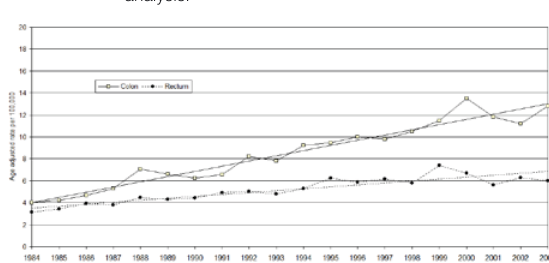
Figure 3. Age adjusted rates of incidence of colon ( □ ) and rectal ( ● ) cancer among Lower Silesian women between 1984 and 2003. The trend lines were determined by line regression analysis.